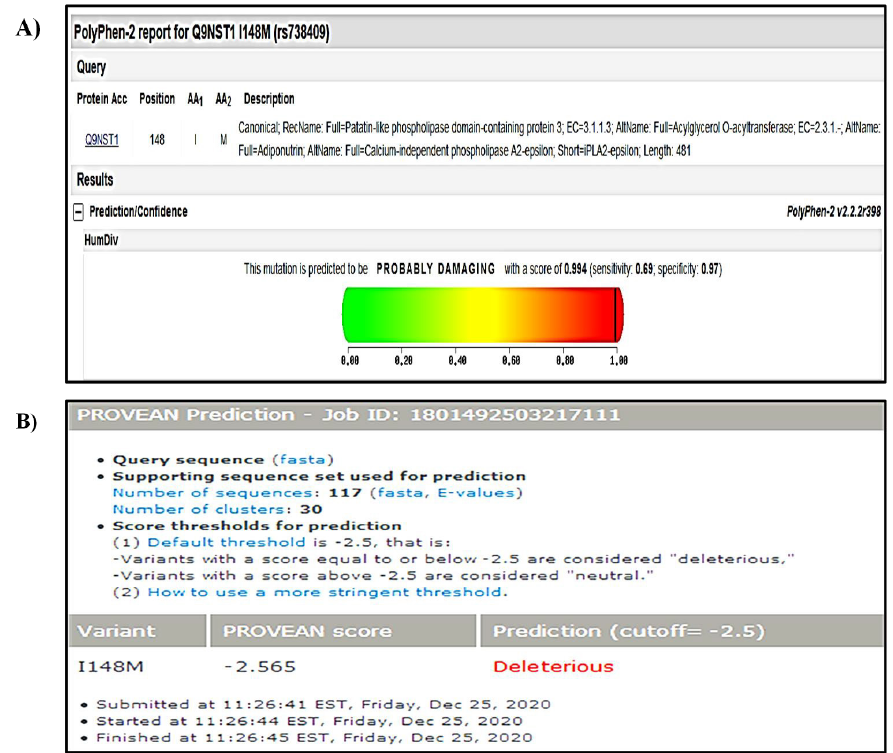
Figure 3. The Result of (A) PolyPhen-2 and (B) PROVEAN Prediction Tools. Note . All results indicate the harmful effect of the I148M